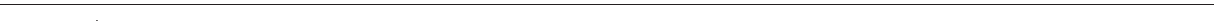
FIGURE 2 | multiskin rash and nodule were observed (yellow arrow) on chest wall, back and face; After 1 month treatment, the multiskin rash and nodule were dramatically improved. (C) Pathology. (a) Nonencapsulated gallbladder lesion (arrow) with ill defined margin (H, E, 4x). (b) Gallbladder lesion of fascicular spindle cells, foamy histiocytes and inflammatory cells (H&E, 20x). (c) adjacent to liver capsule with infiltration of the liver parenchyma (arrow) (H&E, original magnification 4x). (d) Liver lesion of numerous foamy histiocytes admixed with Touton-type giant cells (arrow), spindle cells and inflammatory cells (H&E, 20x). (e) The histiocytes had small dark nuclei to medium-sized folded vesicular nuclei with fine chromatin and small to prominent nucleoli (H&E, 40x). (f) ALK expression with a cytoplasmic staining pattern in histiocyes and Touton-type giant cells (inset). Hepatocytes (arrow) were negative for ALK (20x, inset 40x). (g) Nonencapsulated skin lesion (arrow) with ill defined margin (H&E, 4x). (h) Xanthogranuloma-like appearance of the skin lesion (H&E, 10x). (i) Classic and characteristic moderate- to large-sized foamy histocytes with folded nuclei and small to prominent nucleoli of the liver lesion. Note also a Touton-type giant cells (arrow) (H&E, 40x). (j) CD68 expression in histiocytes of the skin lesion (20x). (k) ALK expression in histocytes of the skin lesion (40x). (l) Break-apart fluorescence in situ hybridization (FISH) assay for ALK gene rearrangements showed positive result with separations of the green and red signals (arrow, 100x). (D) Routine blood test, liver function and lipase/amylase test. No severe liver function, gastrointestinal and hematological toxicity over Grade II (CTCAE 3.0) were observed. For liver function, the levels of AST, ALT, GGT, and albumin were 28 U/l (0–40 U/l), 36 U/l (0–50 U/l), 234 IU/l ( < 60 IU/l), and 36.2 g/l (40–55 µ mol/l), respectively. For routine blood test, WBC and RBC were 7.27 × 10 9 /l (3.6–9.5 × 10 9 /l) and 4.48 × 10 12 /l (4.3–5.8 × 10 12 /l), respectively. For lipase/amylase test, the lipase and amylase were 151 IU/l (13–60 IU/l) and 169 IU/l (344–135 IU/l), respectively. The recurrent pancreatitis was simultaneously cured and was accompanied by lipase/amylase normalization.